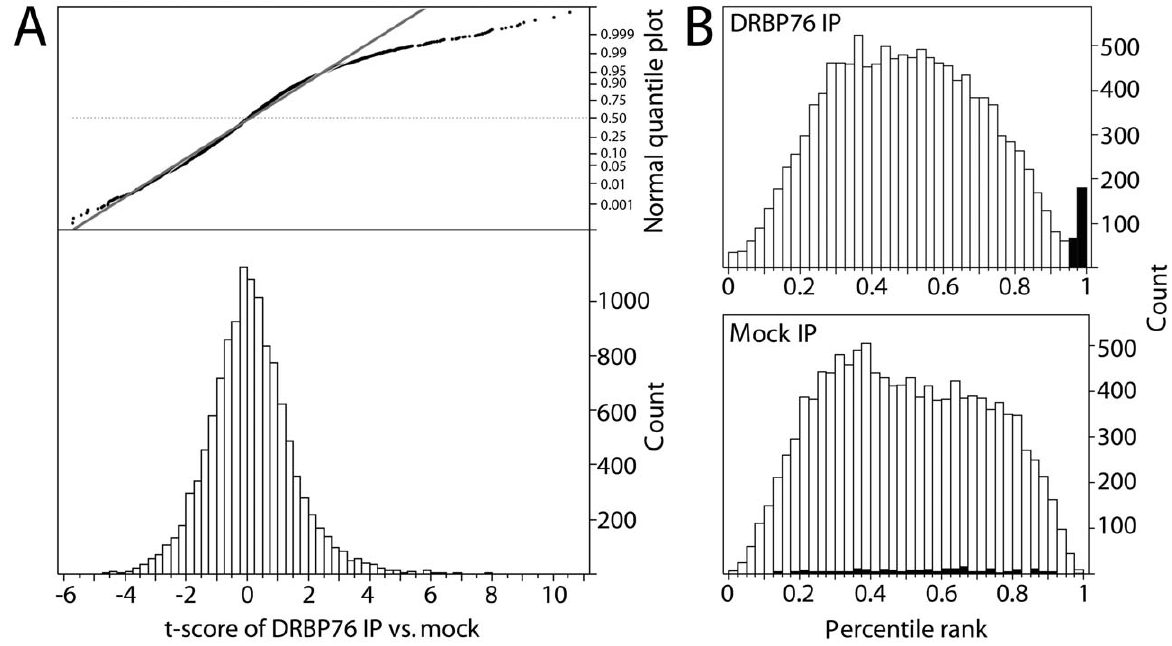
Figure 4. Identification of DRBP76-associated mRNAs using RIP-Chip. A . Distribution of DRBP76 IP vs. mock IP t-scores. Deviation of data from the diagonal quantile:quantile plot indicates the non-Gaussian nature of the DRBP76 IP vs. mock IP distribution, corresponding with transcripts specifically enriched in the DRBP76 IP. B . Distribution of the average percentile ranks (APR) of 5 biological replicates for DRBP76 IPs and mock IPs. Transcripts considered DRBP76 RNP-associated are indicated by black boxes.